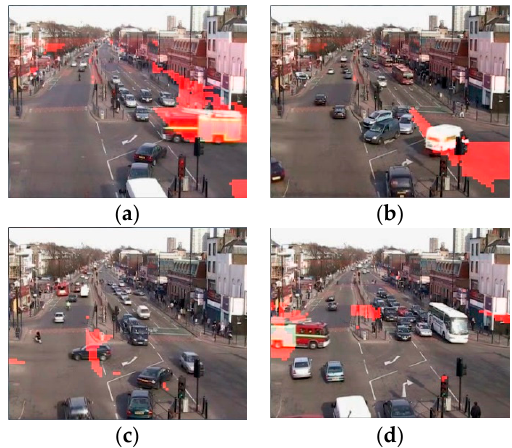
Figure 14. Comparative results of ROC on real video.